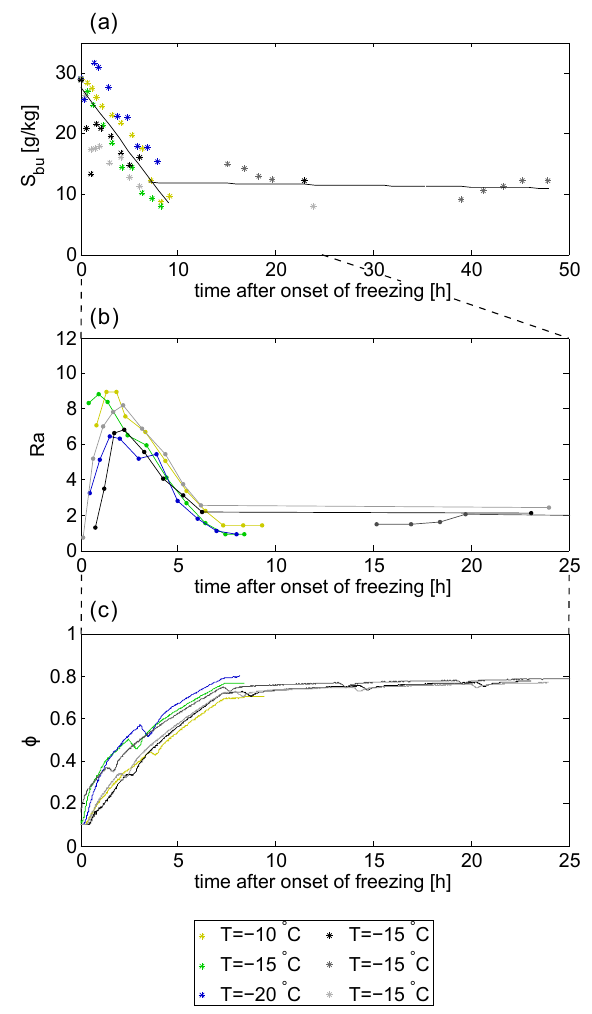
Fig. 8. Temporal evolution of (a) the bulk salinity, (b) the Rayleigh number and (c) the solid fraction in the different quiescent experi- ments. The initial salinity for each experiment is indicated in (a) at the origin of the time axes. Color coding of the experiments corre- sponds to the legend at the